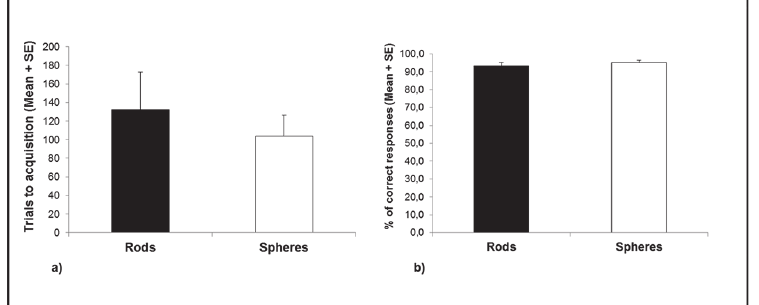
Fig 4. Monkeys ’ performance in Experiment 2. Monkeys ’ performance in the Object condition as a function of stimulus shape (rods and spheres) was reported considering: (a) the number of trials to achieve the learning criterion (mean ± SE); and (b) the mean percentage of correct responses in the last three training sessions (mean ±